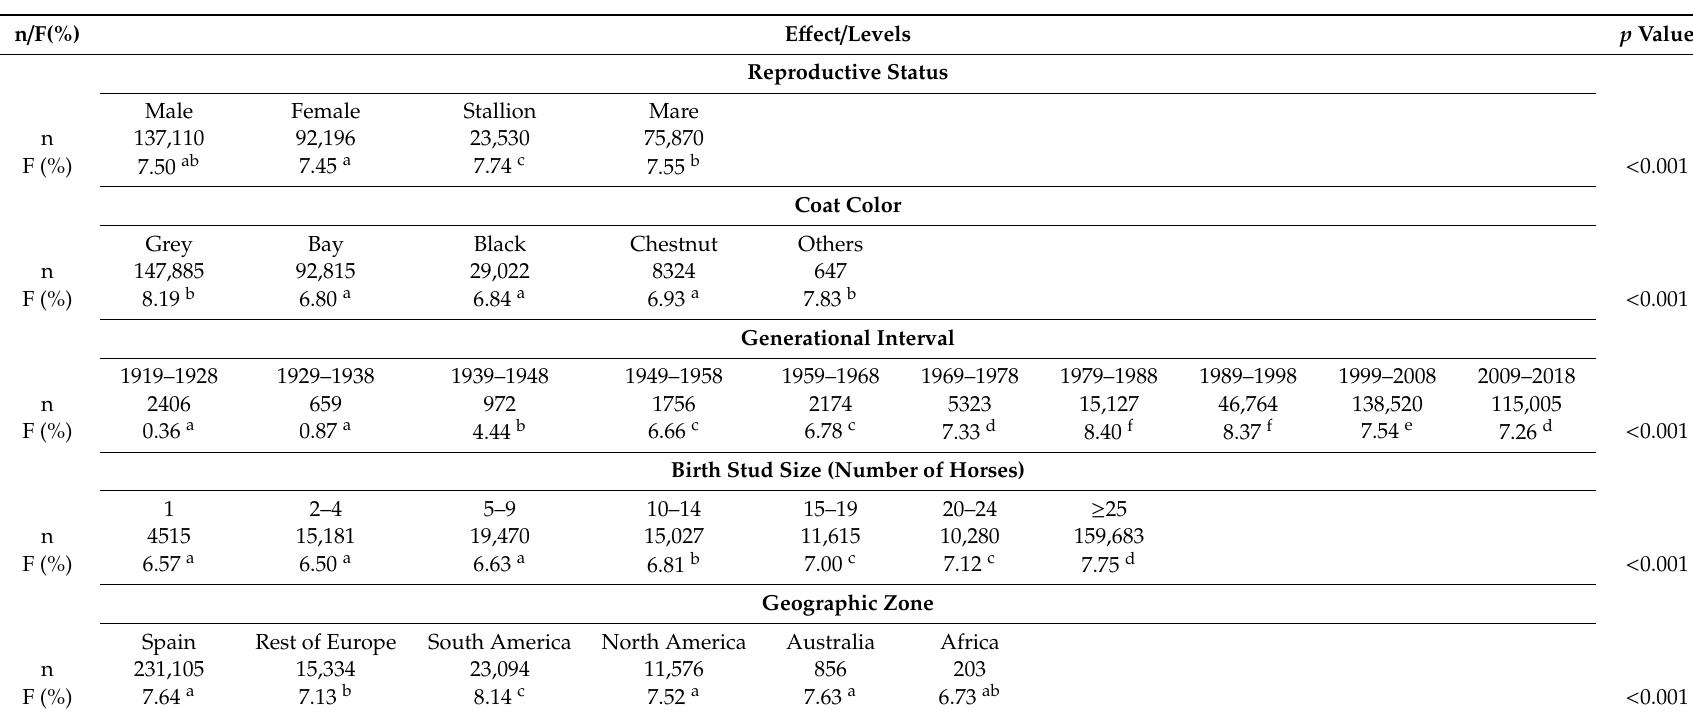
Table 3. Main factors a ff ecting inbreeding coe ffi cient (F, %) in the total population of Pura Raza Español horses. Means comparison with Tukey Least Square Means post hoc